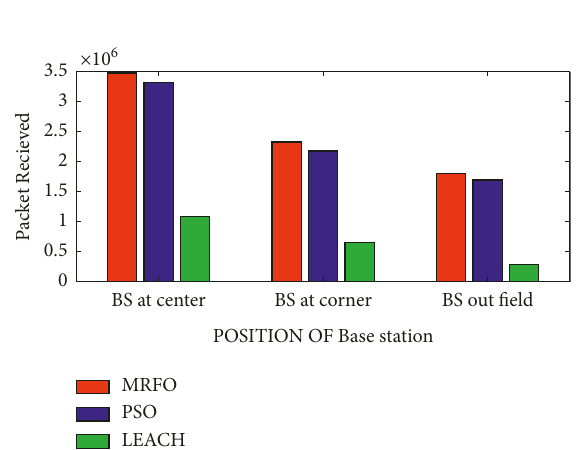
Figure 23: Number of packets received for 500-node network with 50 CHs.